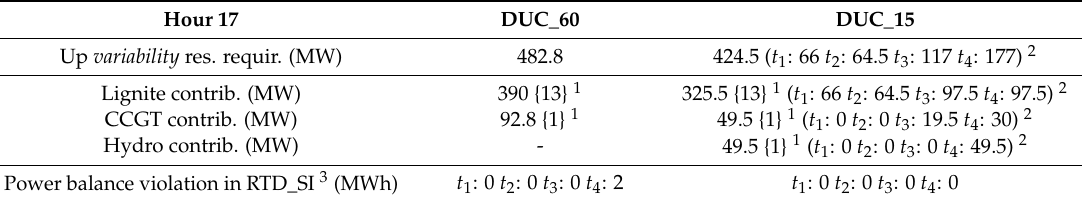
Table 2. Variability reserve allocation: Comparison between DUC_60 and DUC_15 policies. Hour 17 Up variability res. requir.